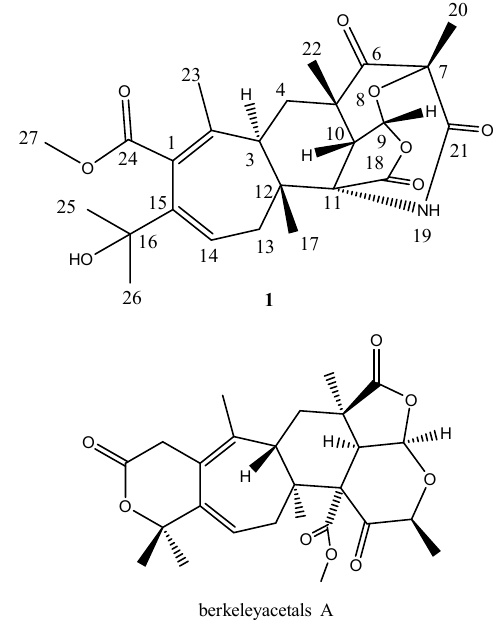
Figure 5. Structures of compound 1 and berkeleyacetal A [13].